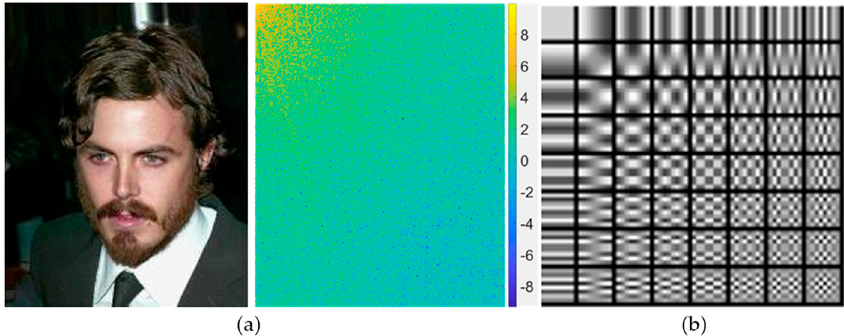
Figure 6. ( a ) 2D DCT example; ( b ) 8 × 8 cosine basis functions.